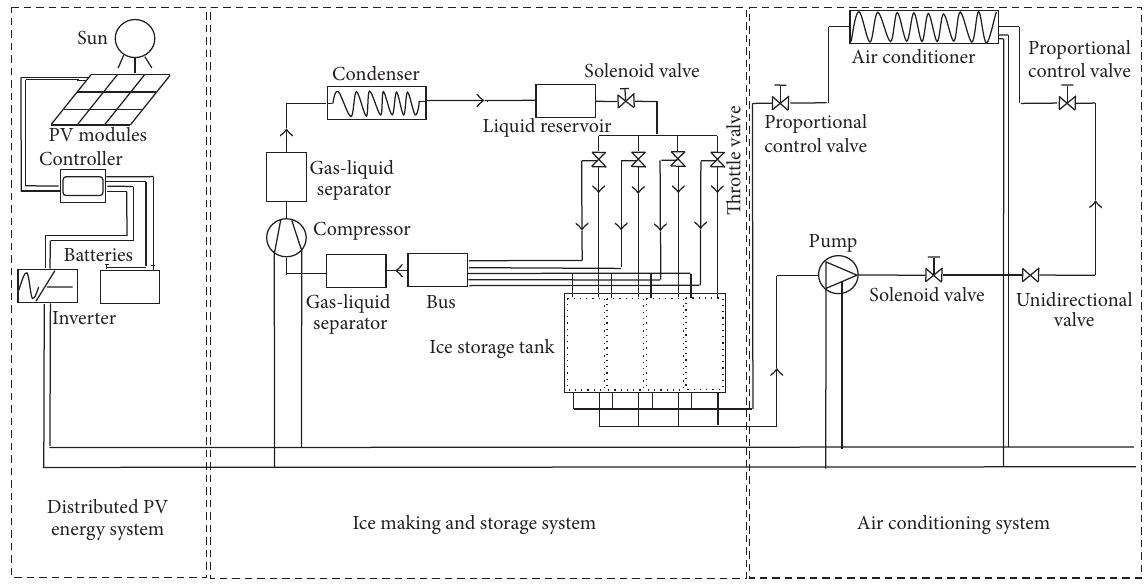
Figure 1: Work diagram of ISACS driven by DPES with